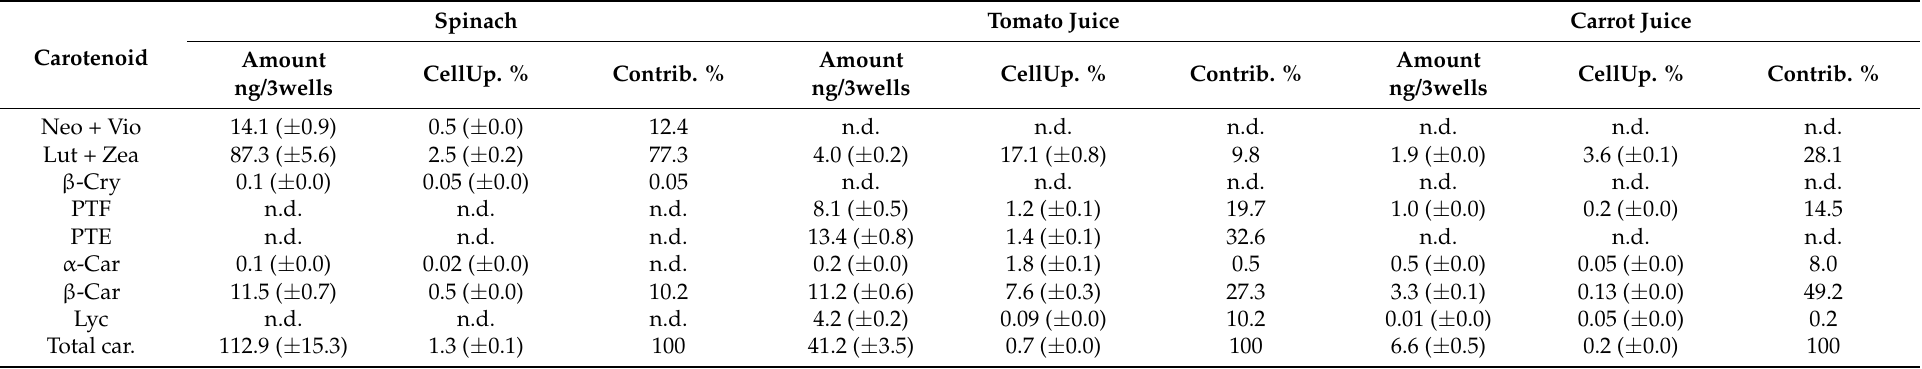
Table 3. Absolute amount 1 of carotenoids, percentage of their cellular uptake 2 , as well as their relative contribution to cellular uptake 3 to total carotenoids in the fractional cellular uptake phase of carotenoids into Caco-2 cells, as determined by LC-MS-MS. Values represent means of n = 3 measurements.